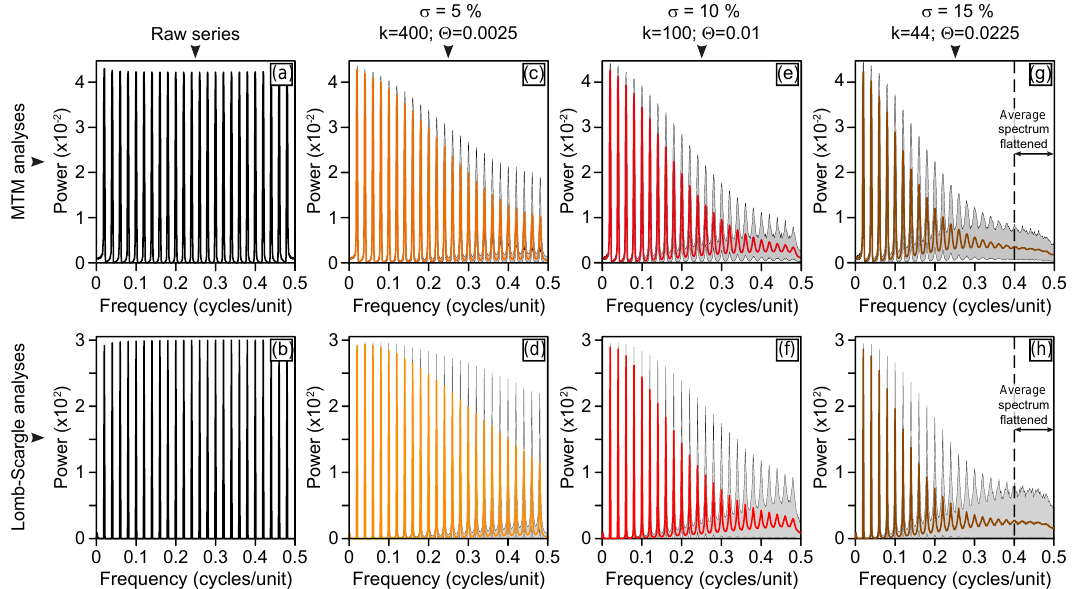
Figure 3. Effect of the gamma-law randomised sample distances on the 2 π MTM and Lomb–Scargle spectra of the series of sum of pure sinusoids. Panels (a) and (b) : spectra of the series without sample step randomisation. Panels (c) and (d) : spectra with 5% of stratigraphic uncertainty. Panels (e) and (f) : spectra with 10% of stratigraphic uncertainty. Panels (g) and (h) : spectra with 15% of stratigraphic uncertainty. For each simulation shown from (c) to (h) , the grey area represents the interval covering 95% of the simulations, while the red, orange and brown curves represent the average